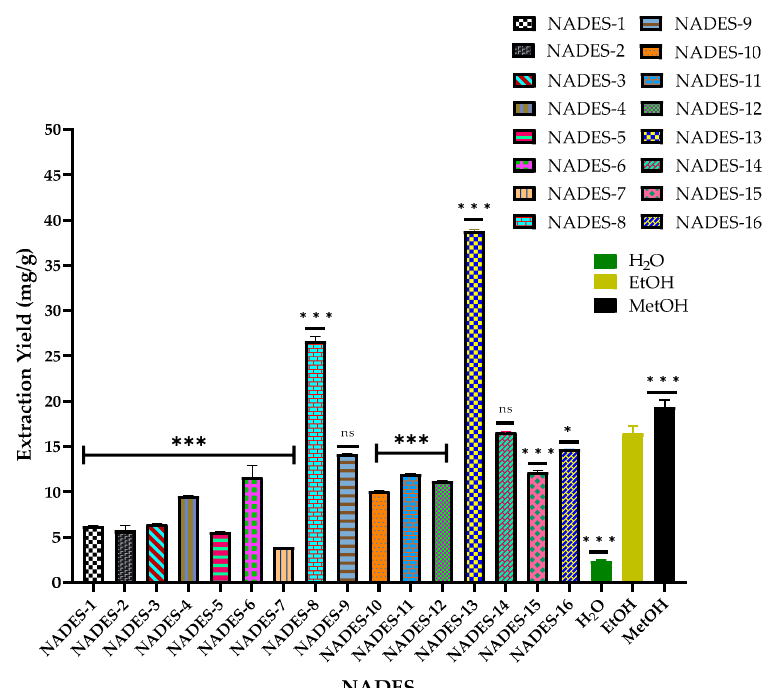
Figure 3. Extraction yield (mg/g) of NADESs and three conventional solvents. Black bars and asterisks refer to the degree of significance of all solvents against ethanol. One-way ANOVA was used to analyze the data, followed by Sidak’s multiple comparisons.